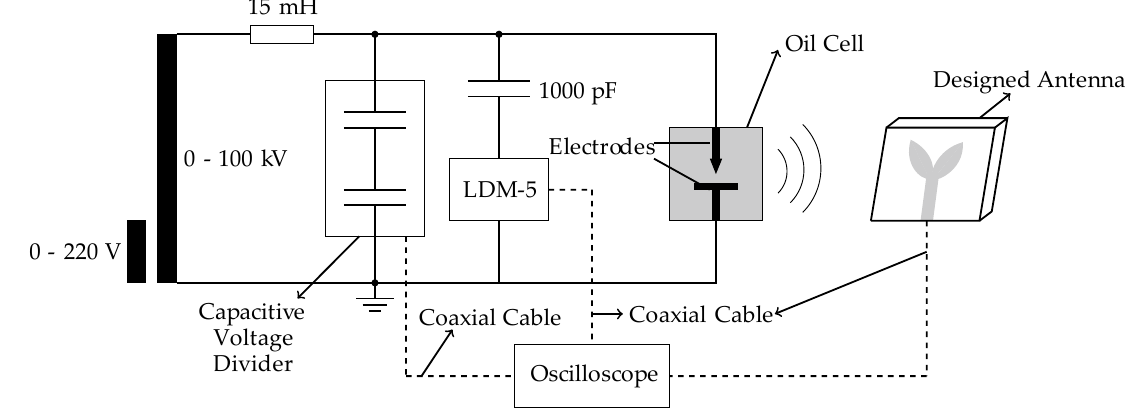
Figure 7. PD detection sensitivity test. Sensors 2019 , 19 , x